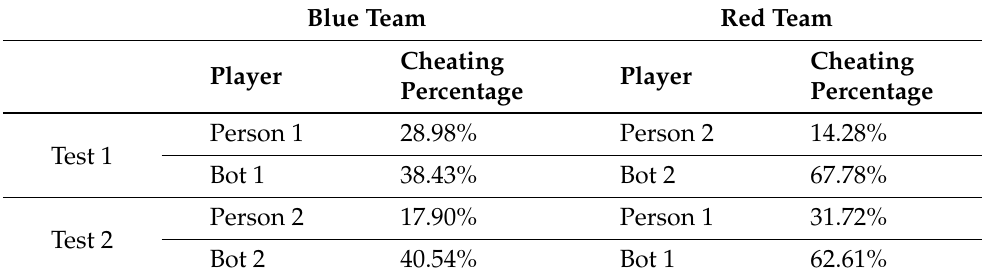
Table 3. Result of 2v2